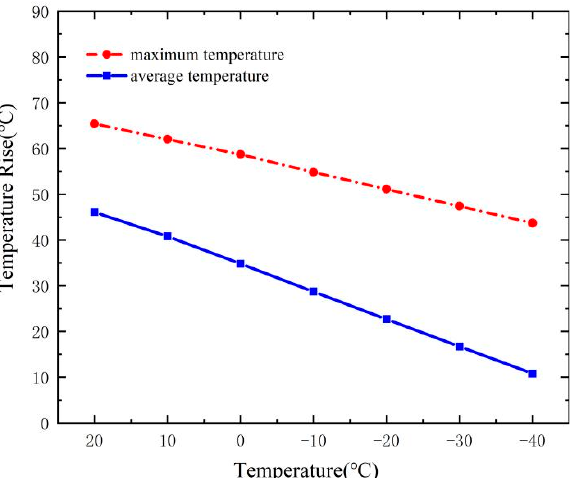
Figure 5. Maximum and average temperatures rise in benchmark and precooling cylinders (t = 90 s).